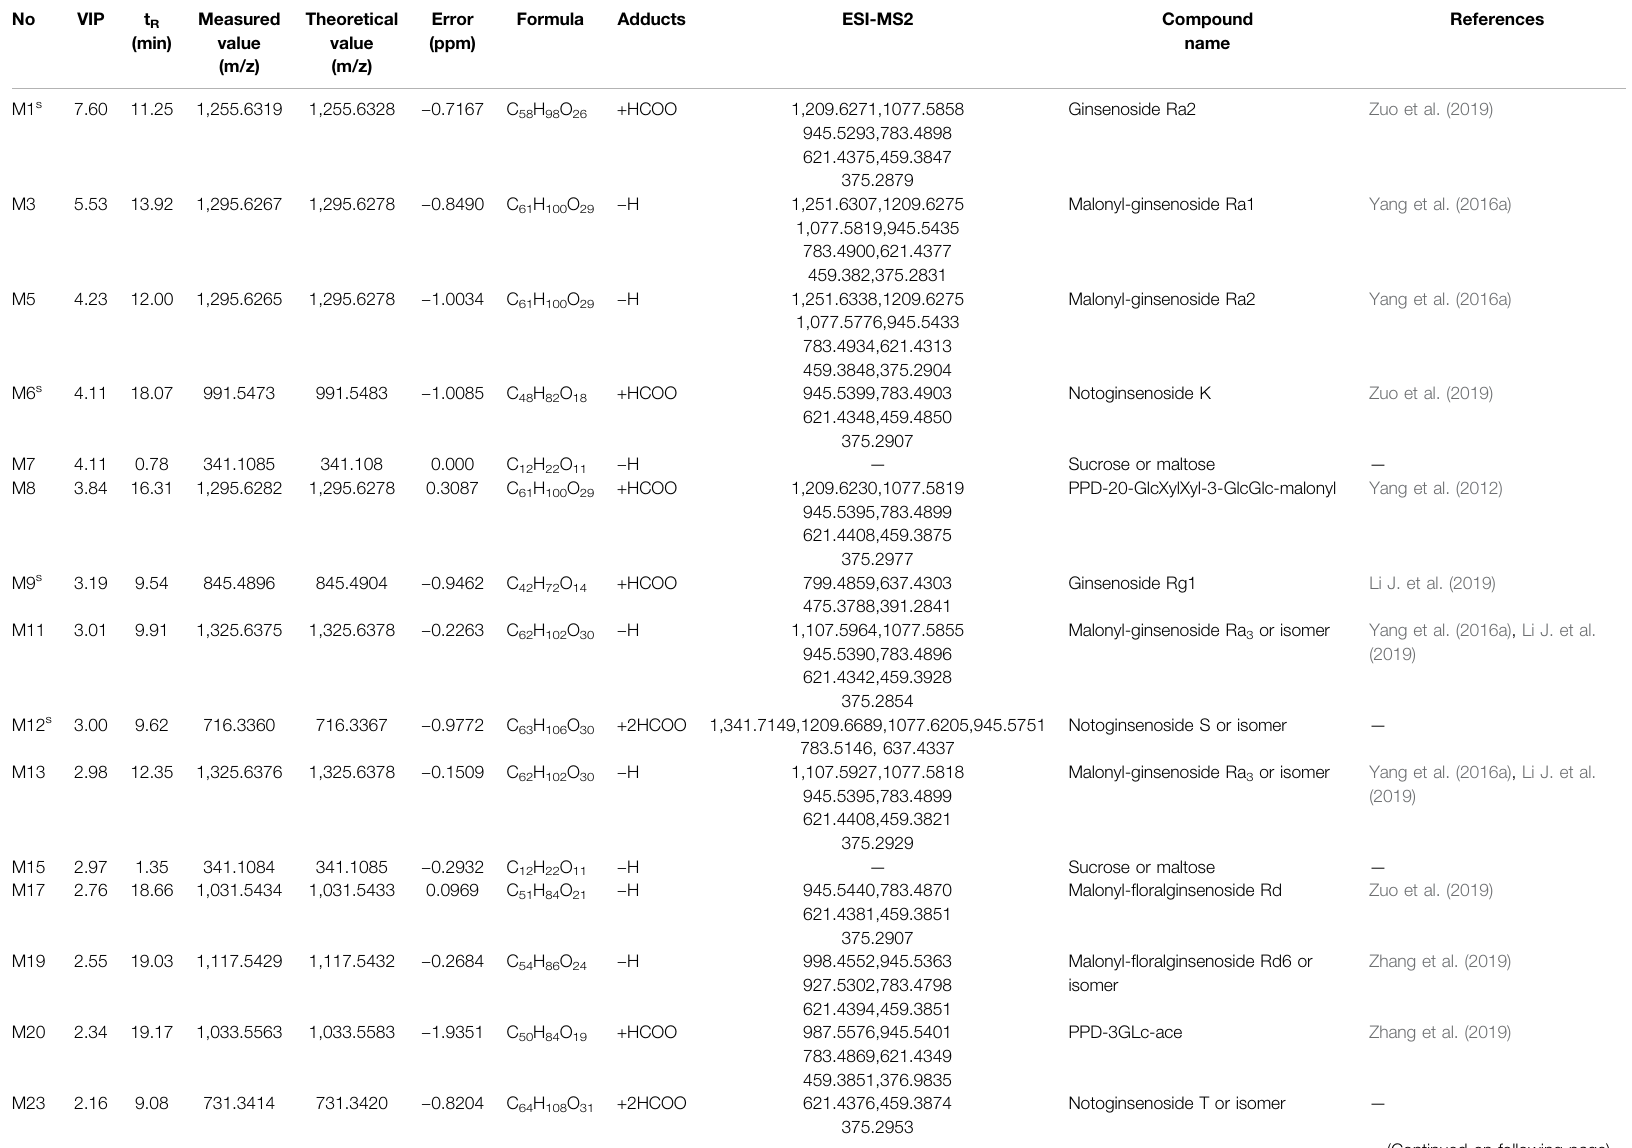
TABLE 1 | Information of ginsenoside markers for differentiating among MCG and